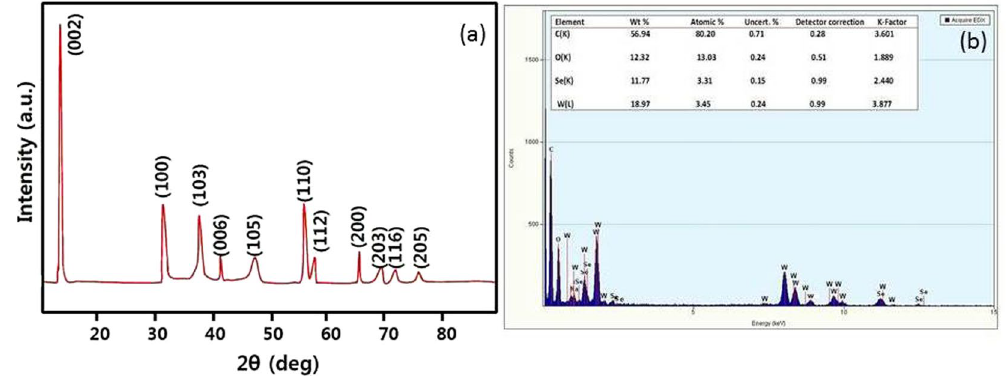
Figure 2. ( a ) XRD pattern and ( b ) EDX of WSe 2 -graphene composite.